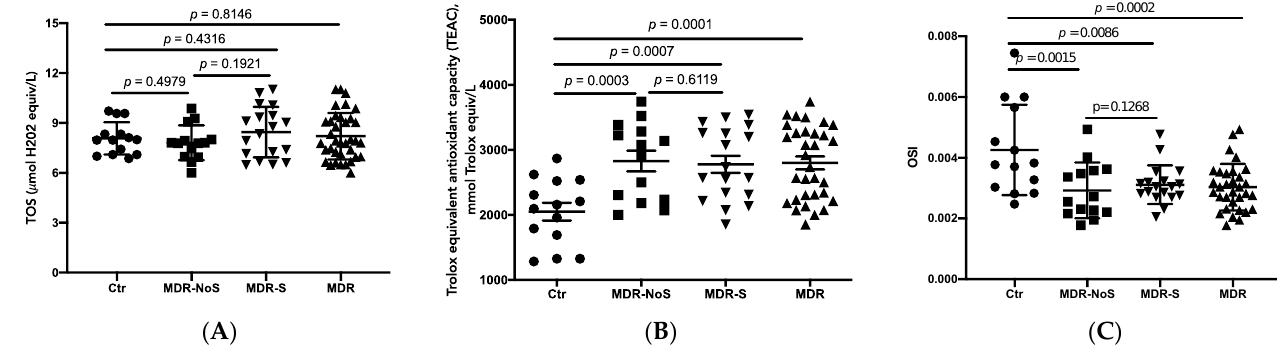
Figure 2. Total oxidative status (TOS) ( A ), Trolox equivalent antioxidant capacity (TEAC) ( B ), and oxidative stress index (TOS/TEAC, OSI) ( C ) were determined in the serum extracted from sedentary controls (CTR), middle distance runners not taking antioxidant supplements (MDR-NoS) and MDR taking antioxidant supplements (MDR-S). MDR indicates all the MDR irrespective of antioxidant supplementation. CTR, MDR-NoS, MDR-S, and MDR are respectively indicated with a black circle, black square, black triangle with the vertex at the bottom, and black triangle with the vertex at the top. All data are expressed as mean ± SD.